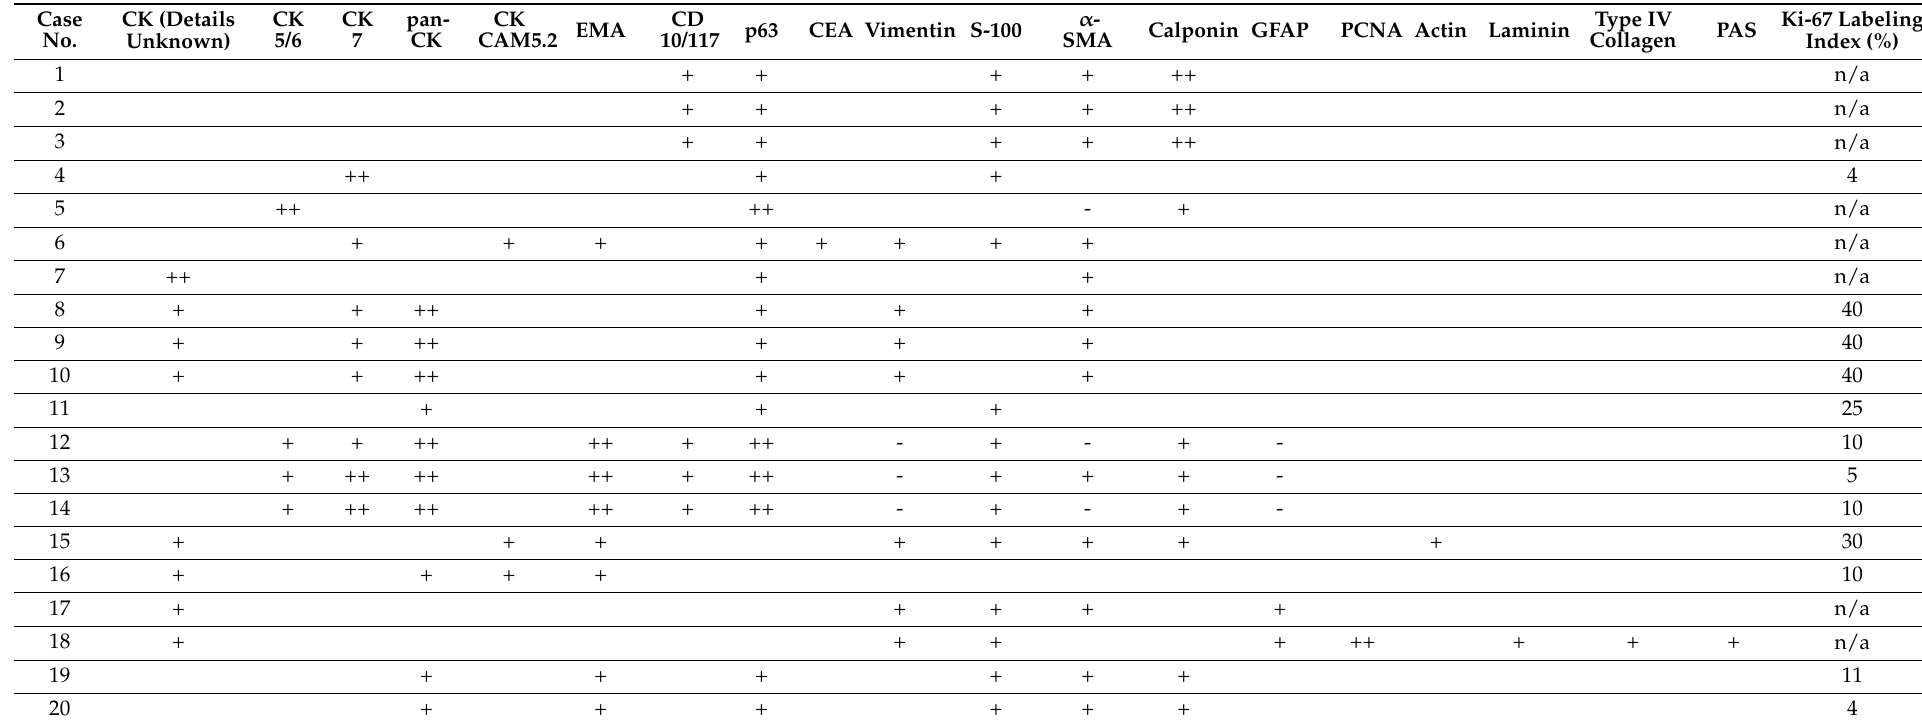
Table 2. Antibodies and results of immunohistochemical